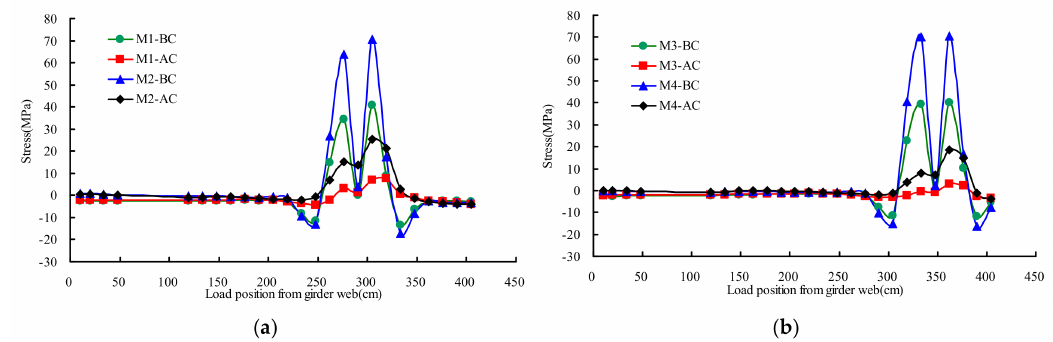
Figure 14. Stresses of deck plate under transverse wheel positions: ( a ) M1 and M2; ( b ) M3 and M4.